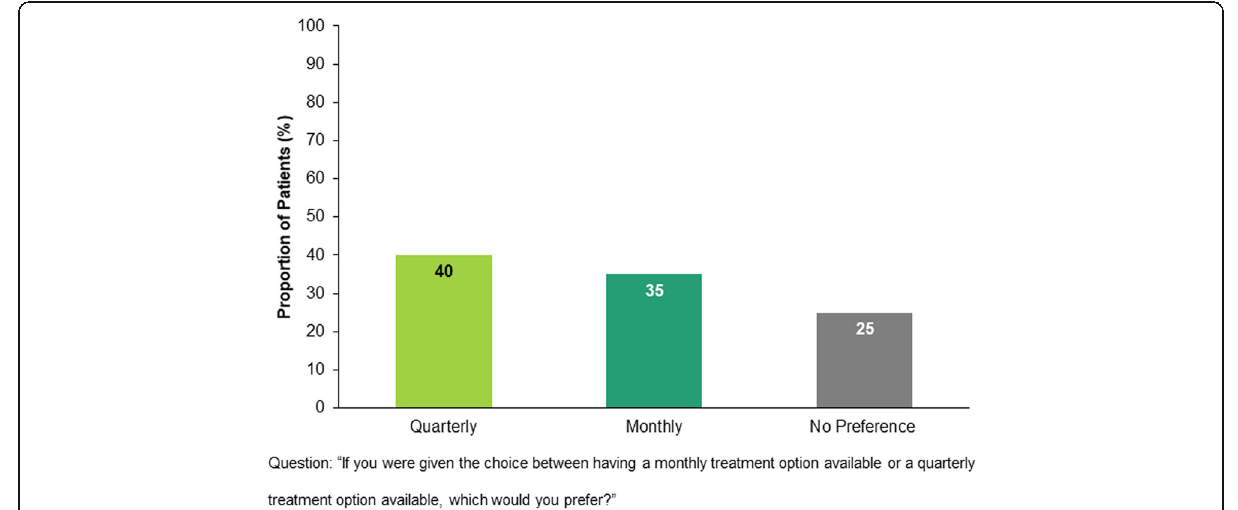
Fig. 4 Patients preference: Monthly dosing, quarterly dosing, or on